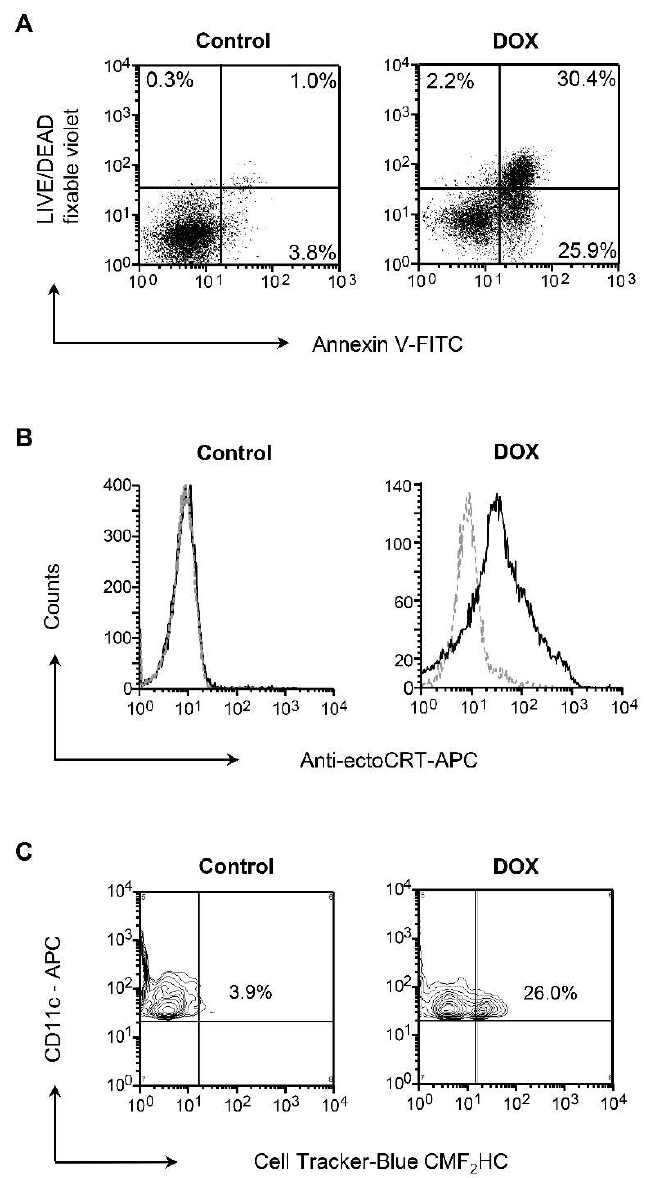
Figure 1. Doxorubicin (Dox)-induced apoptosis is associated with surface exposure of calreticulin (CRT) and phagocytosis of tumor cell debris by bone marrow (BM)-derived dendritic cells (DCs). ( A ) Cell death in murine neuroblastoma tumor cells (NXS2) treated with Dox (10 µ M) was determined by staining with Annexin V conjugated with fluorescein isothiocyanate (Annexin V-FITC) and LIVE/DEAD fixable violet to measure the induction of early apoptosis (Annexin V + /LIVE/DEAD fixable violet - ) and late apoptosis/necrosis (Annexin V + /LIVE/DEAD fixable violet + ) by flow cytometry 24 h later. One representative experiment of three independent experiments performed is shown. ( B ) Surface exposure of CRT in NXS2 culture untreated or treated with Dox was determined by flow cytometry after staining with an anti-CRT Ab or an isotype control 24 h after treatment. One representative experiment of three independent experiments performed is shown. ( C ) Mouse BM-derived DCs were co-cultured with cell tracker-blue CMF 2 HC-labeled NXS2 cells (1:1 ratio) for 12 h and analyzed for phagocytosis by flow cytometry. The percentages of CD11c-expressing DCs taking up tumor cells are indicated. One representative experiment of three independent experiments performed is shown.